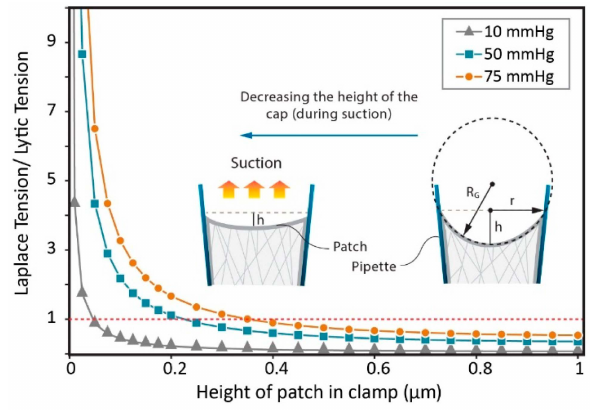
Figure 4. The effect of the flattening of the patch on the ratio of the membrane tension distribution and the lytic tension (calculated using the Laplace